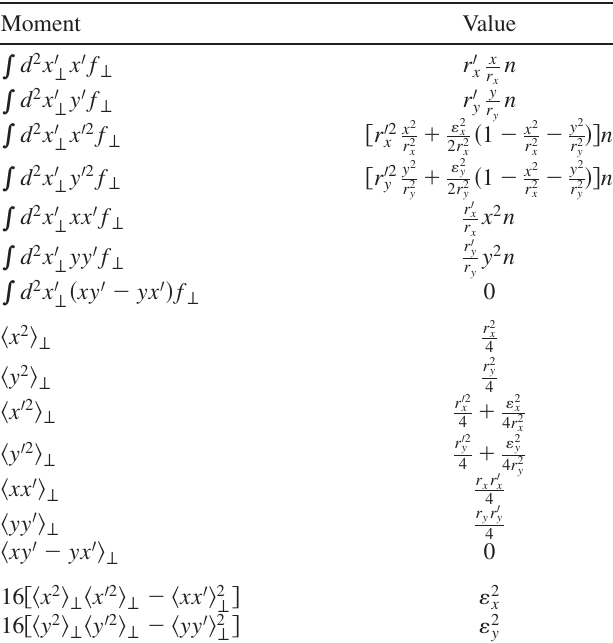
R ¼ 0 , h xy i xyf d 2 x 0 ? ?